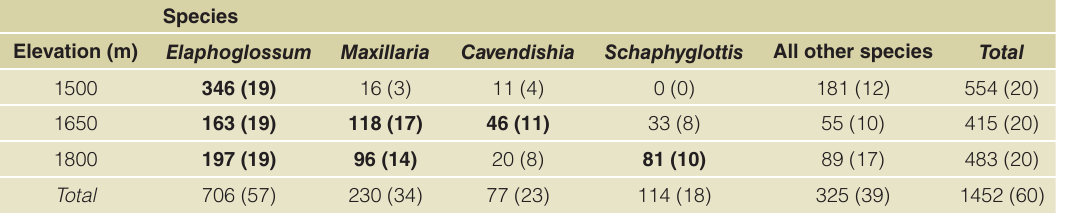
Table 2. Number of ramets in surveyed mats before transplanting. Numbers in parentheses indicate number of mats the ramets were found in. Bold indicates ramets used in single species analyses.